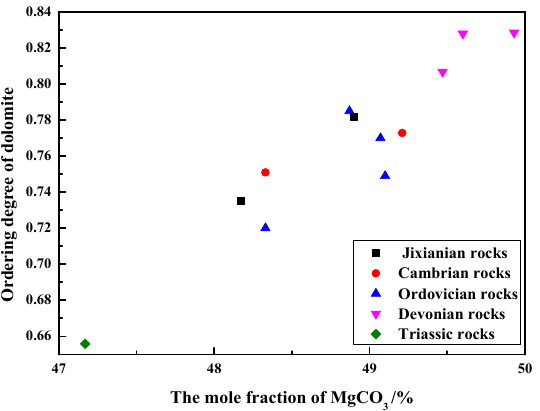
Figure 8. Relationship between ordering degree and the mole fraction of MgCO 3 of dolomites.